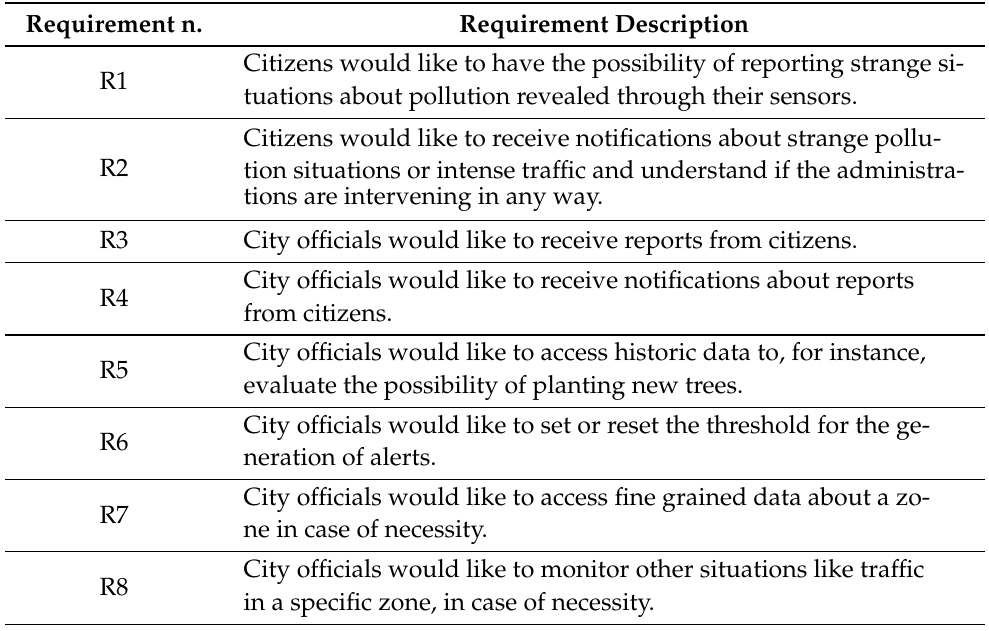
Table 1. Functional requirements.